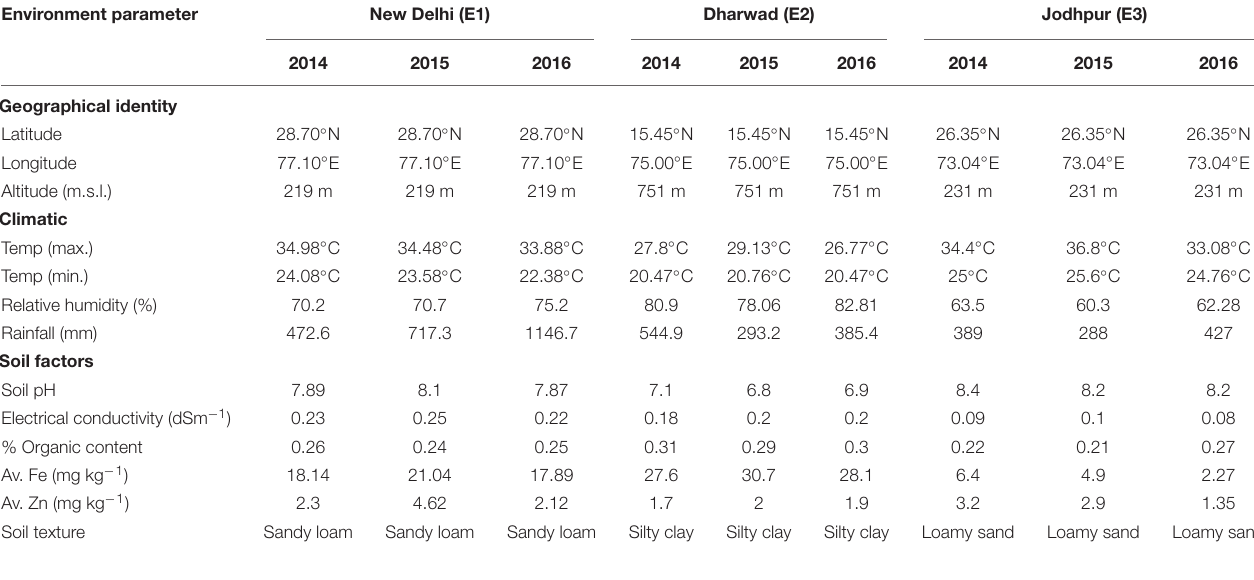
TABLE 2 | Geographical location, climatic, and edaphic factors over different years and locations. Environment